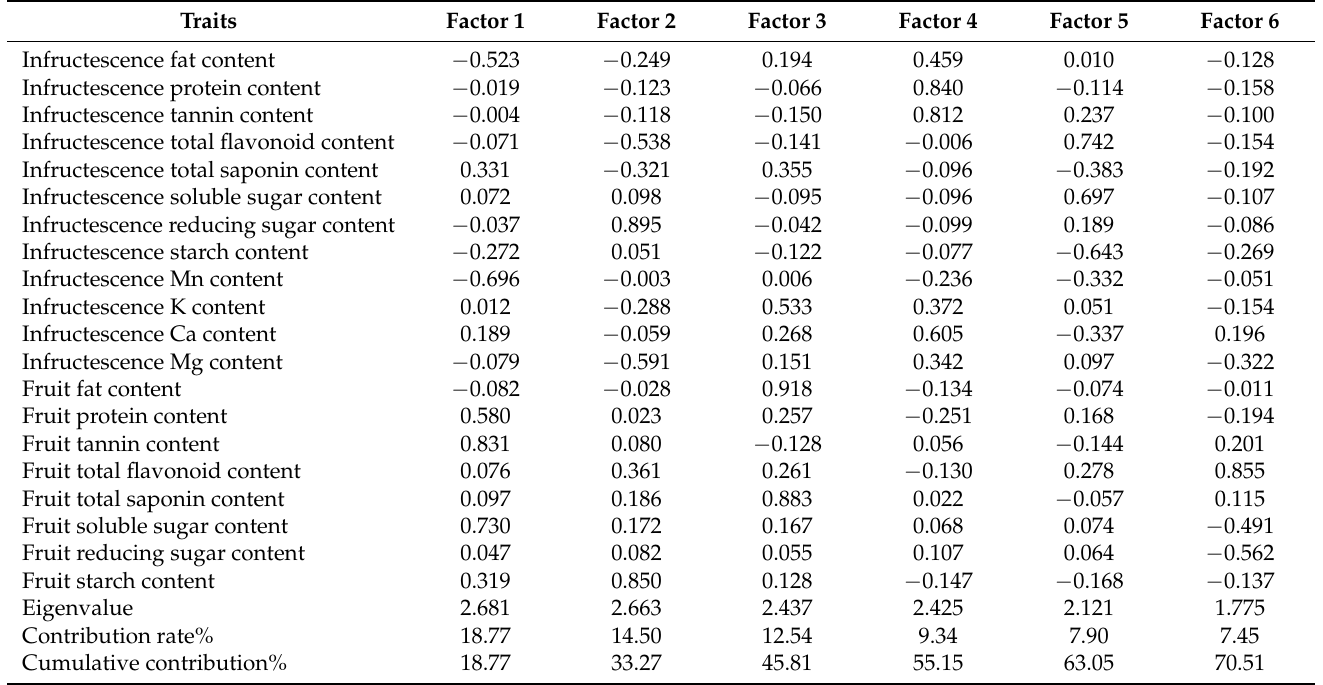
Table 5. Principal component analysis in quality traits of H. acerba